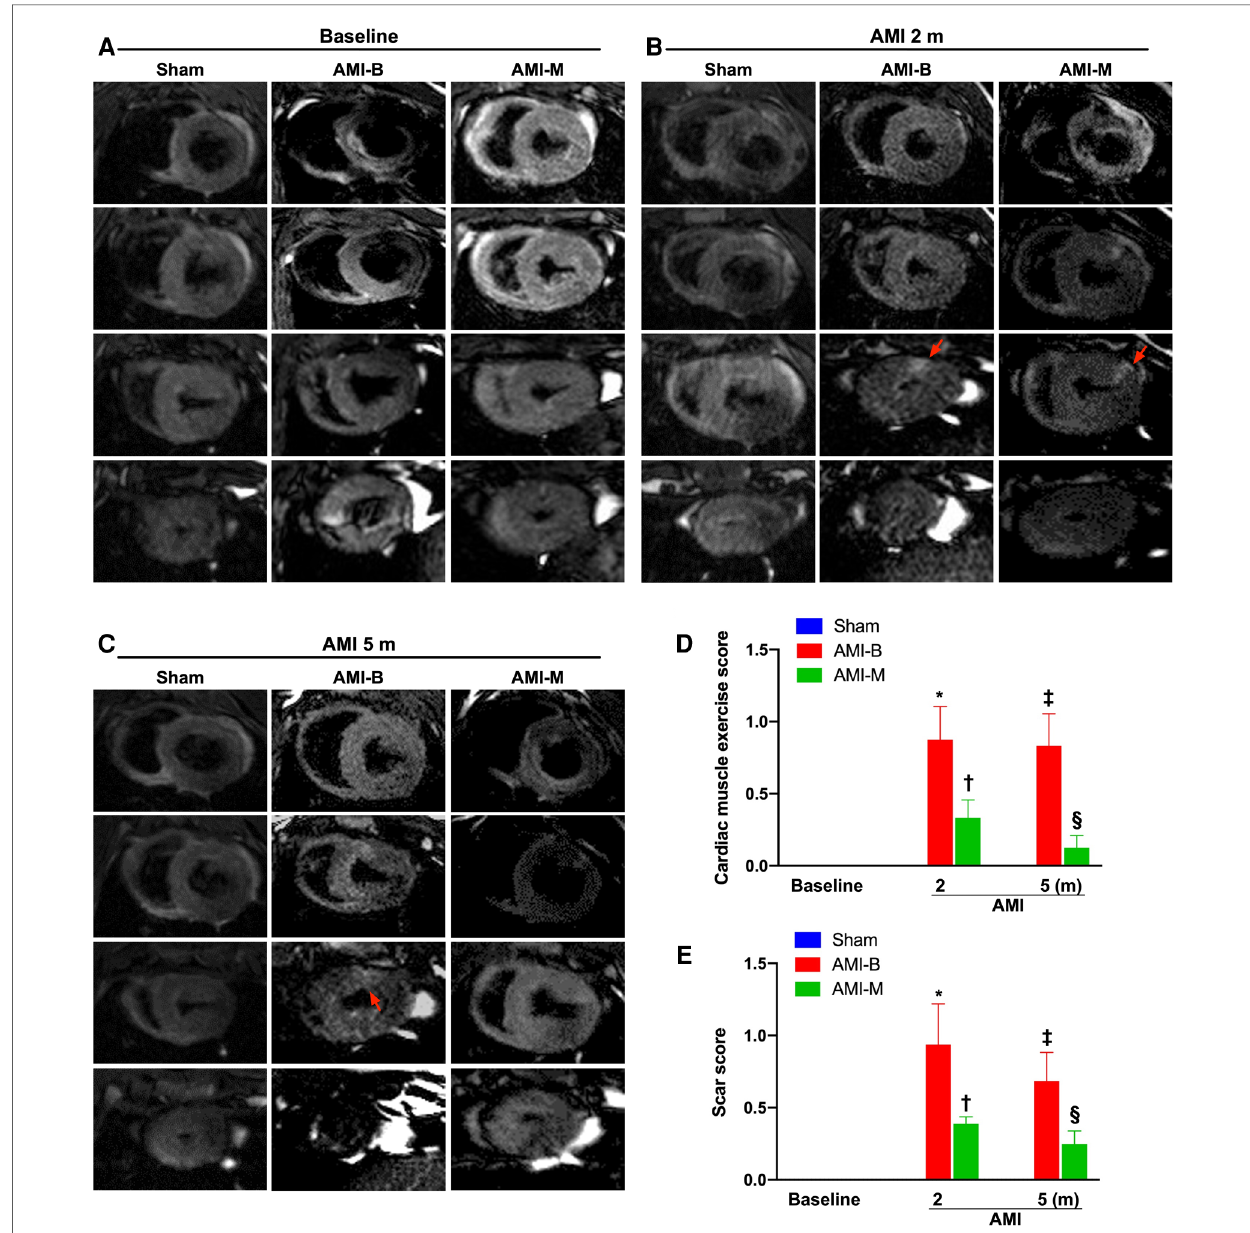
FIGURE 2 Time courses of cardiac MRI evaluations for identi fi cation of abnormal cardiac muscle exercise score and scar score. ( A – C ) The cardiac MRI fi nding for identi fi cation of cardiac muscle exercise score and scar score at baseline ( A ), 2 months after AMI induction ( B ), and 5 months after AMI induction ( C ), respectively. The red arrows indicate myocardial scars. ( D ) Analytical result of abnormal cardiac muscle exercise score 2 months after AMI induction, * vs. † , p <0.001; analytical result of abnormal cardiac muscle exercise score 5 months after AMI induction, ‡ vs. §, p <0.0001. ( E ) Analytical result of myocardial scar score 2 months after AMI induction, * vs. † , p <0.001; analytical result of myocardial scar score 5 months after AMI induction, ‡ vs. §, p <0.0001. Sham (group 1), sham-operated control; AMI-B (group 2), AMI+buffer; AMI-M (group 3), AMI+hBMMSC; AMI, acute myocardial infarction; hBMMSCs, human bone marrow-derived mesenchymal stem cells; MRI, magnetic resonance